Question: Condense the content of this figure into a single sentence.
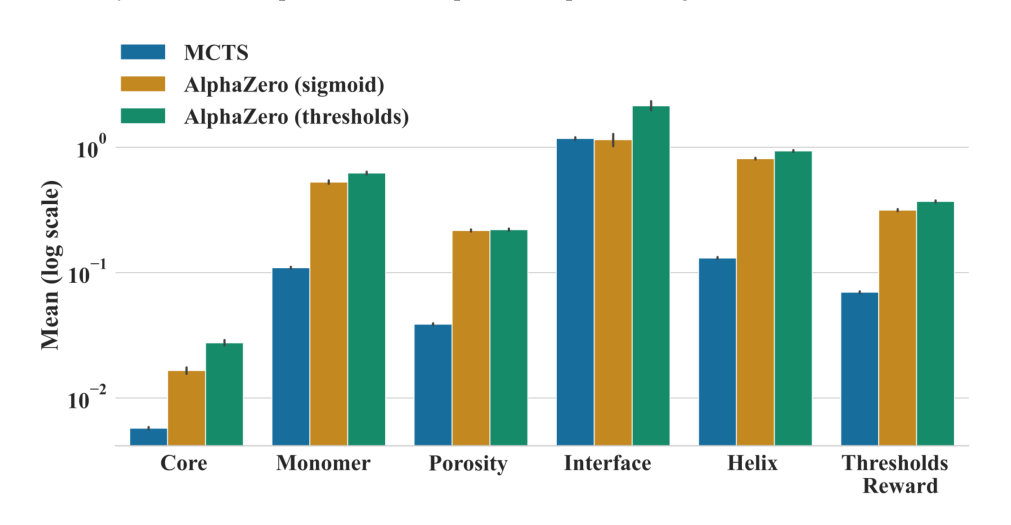
Answer: Protein score distributions means with 95% bootstrap confidence intervals. AlphaZero, and more specifically AlphaZero (thresholds) systematically outperforms MCTS on all scores.